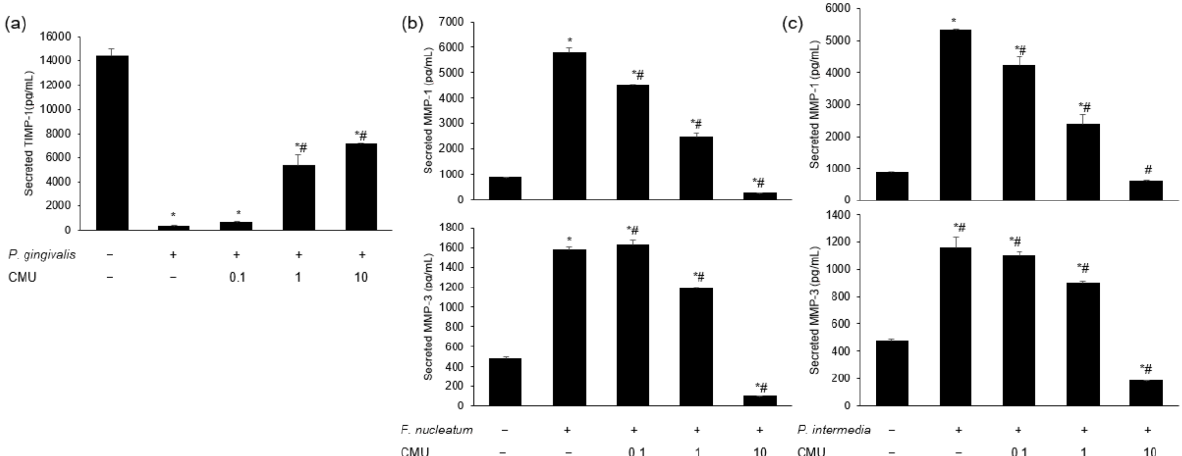
Figure 8. Dose-dependent effects of W. cibaria CMU on the protein expression of TIMP-1, MMP-1, and MMP-3 induced by P. gingivalis ( a ), F. nucleatum ( b ), and P. intermedia ( c ). HGFs were pre-treated with W. cibaria CMU for 30 min at various doses (0.1, 1, and 10) and then incubated with P. gingivalis , F. nucleatum , or P. intermedia (MOI = 100) for 24 h. CMU, W. cibaria CMU. Data are presented as the mean ± standard deviation. * p < 0.05, compared to the untreated group. # p < 0.05, compared to the control group.